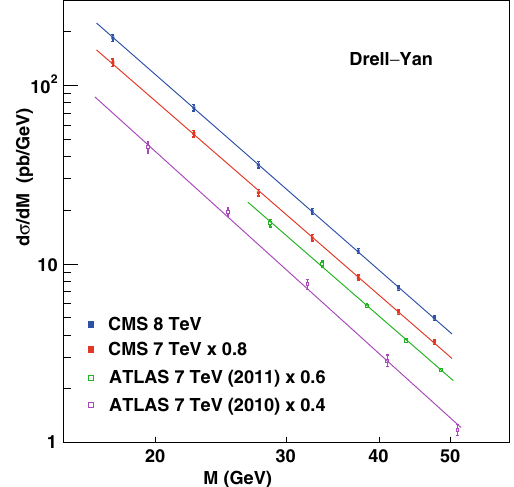
Fig. 1 Mid-rapidity Drell–Yan differential cross sections as a function of the dilepton mass, as measured by ATLAS [12] and CMS [13,14] √ s / M is universal :itsshapedoesnot variables p T / M , y ,and depend on M . At any given kinematic point (( p T / M ) (cid:5) , y (cid:5) ) √ s ,thed σ/ d p T crosssectionscaleslike M − ( 3 + β) ,where and β expresses the increase of the integrated cross section with √ s . The scaling of the cross section with M , integrated over p T , was previously discussed in Ref. [11], but